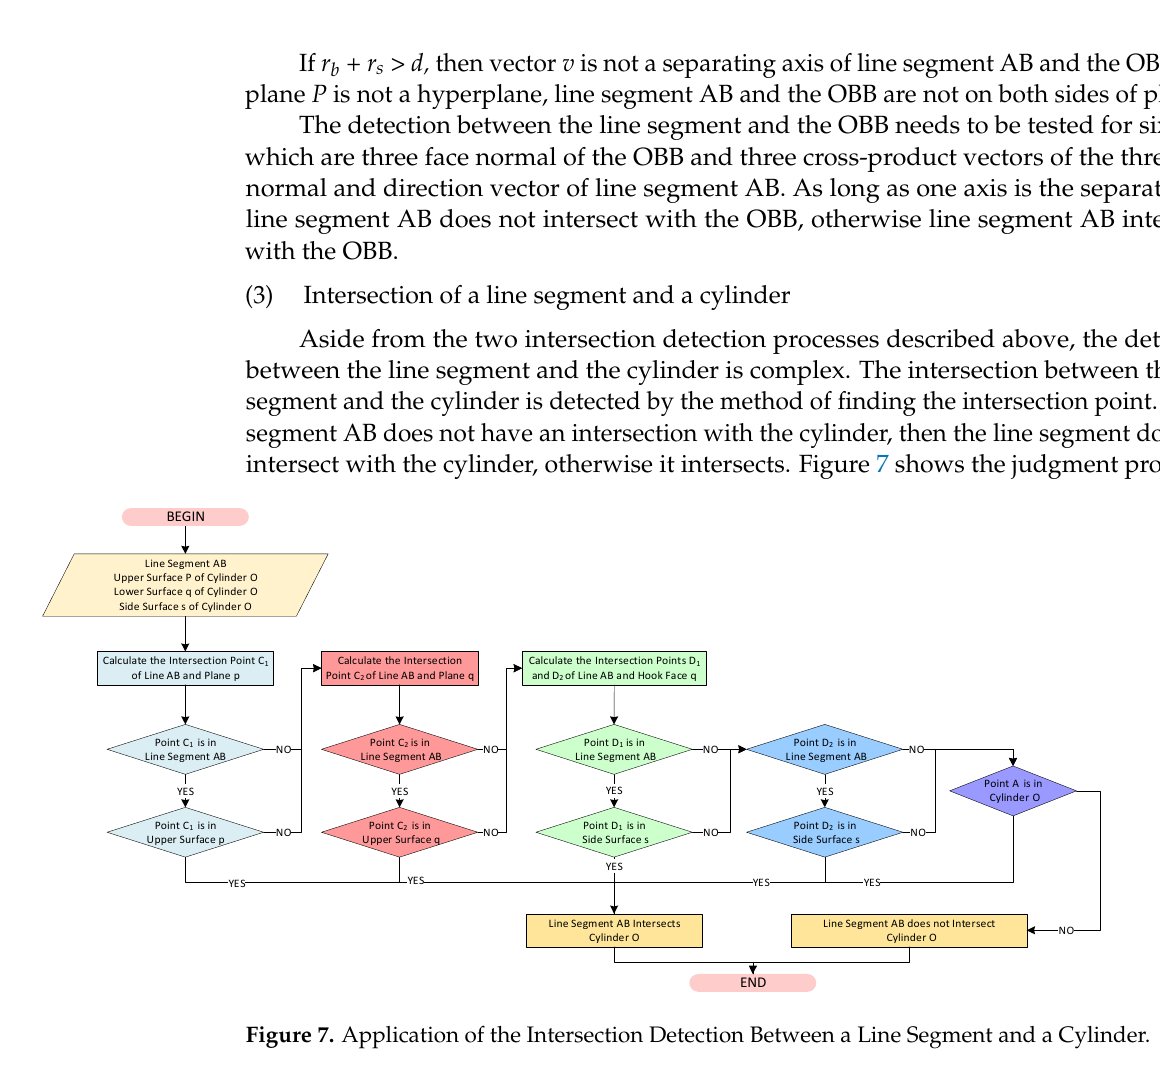
Figure 6. Diagram of the Intersection Detection of a Line Segment and an OBB.